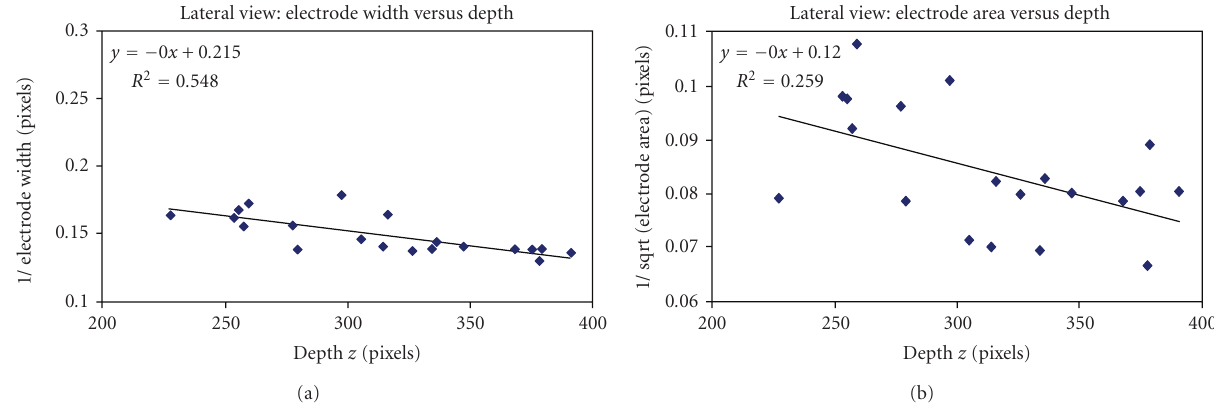
Figure 13: (a) Inverse of the projection width w versus depth z . (b) Inverse of the projection area A versus depth z . The width calculation yields statistically significant result when compared to width calculation.